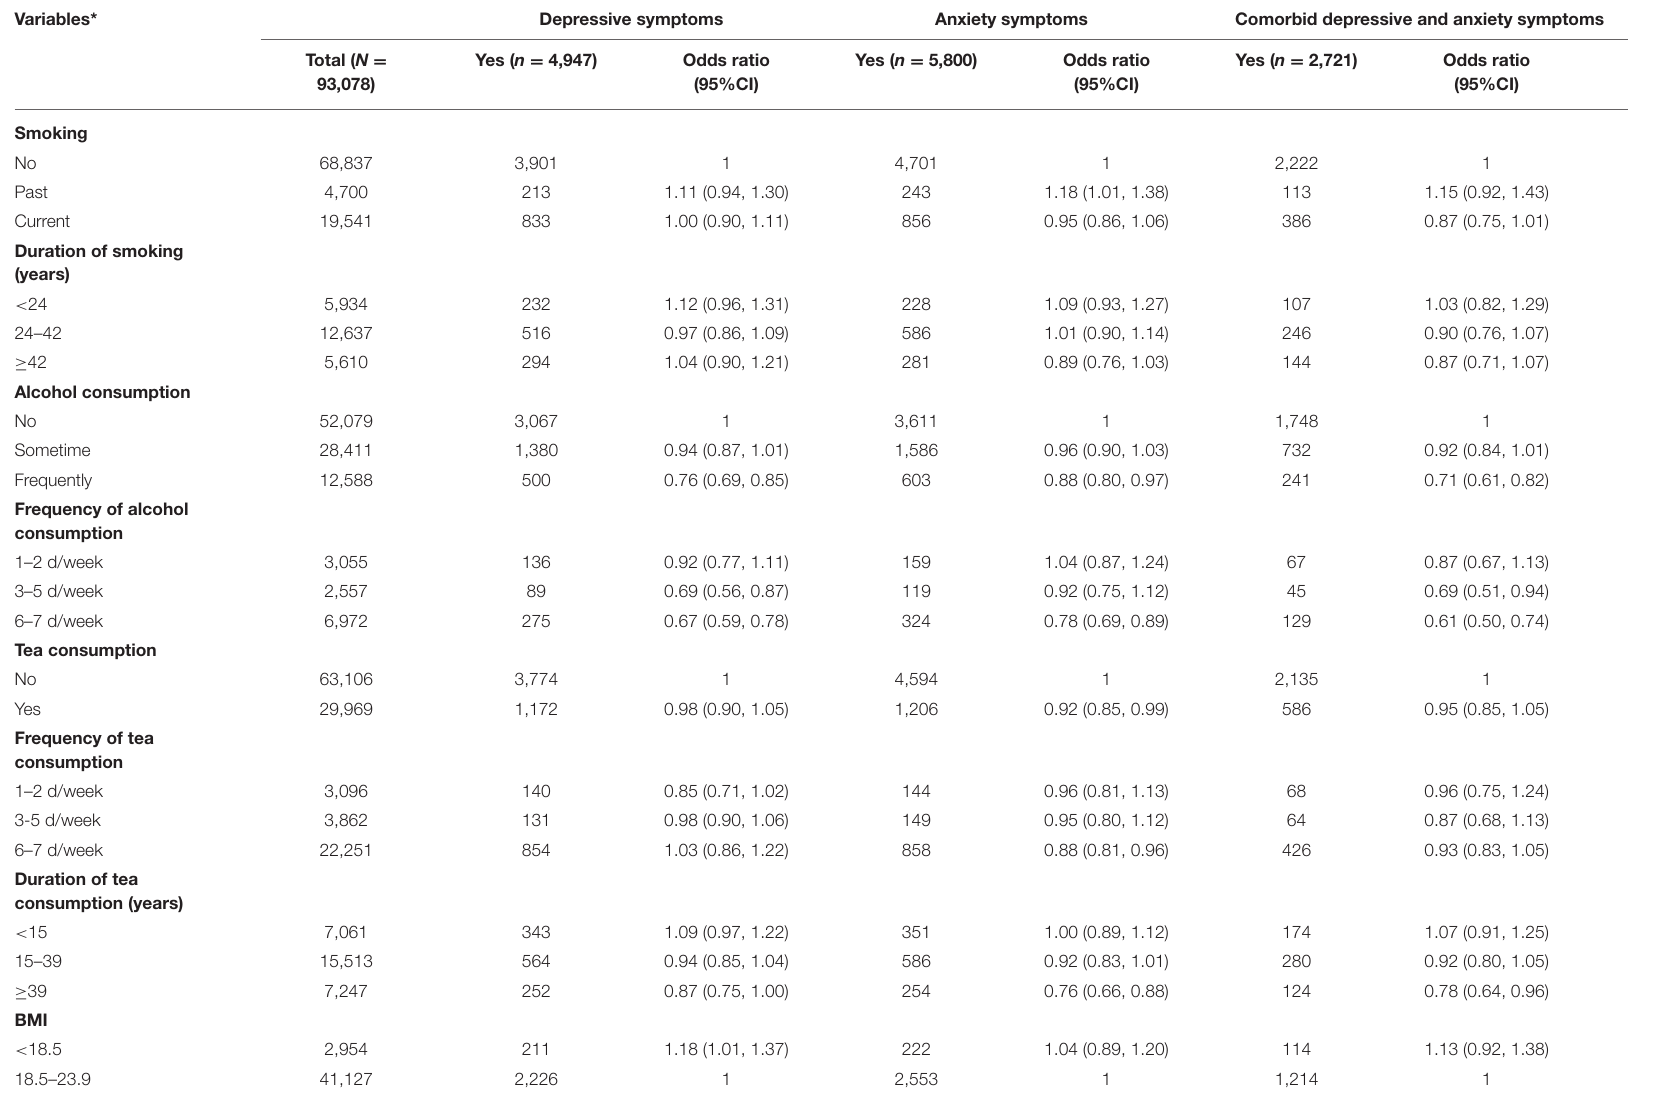
TABLE 2 | Associations of lifestyles and behaviors with comorbid depressive and anxiety